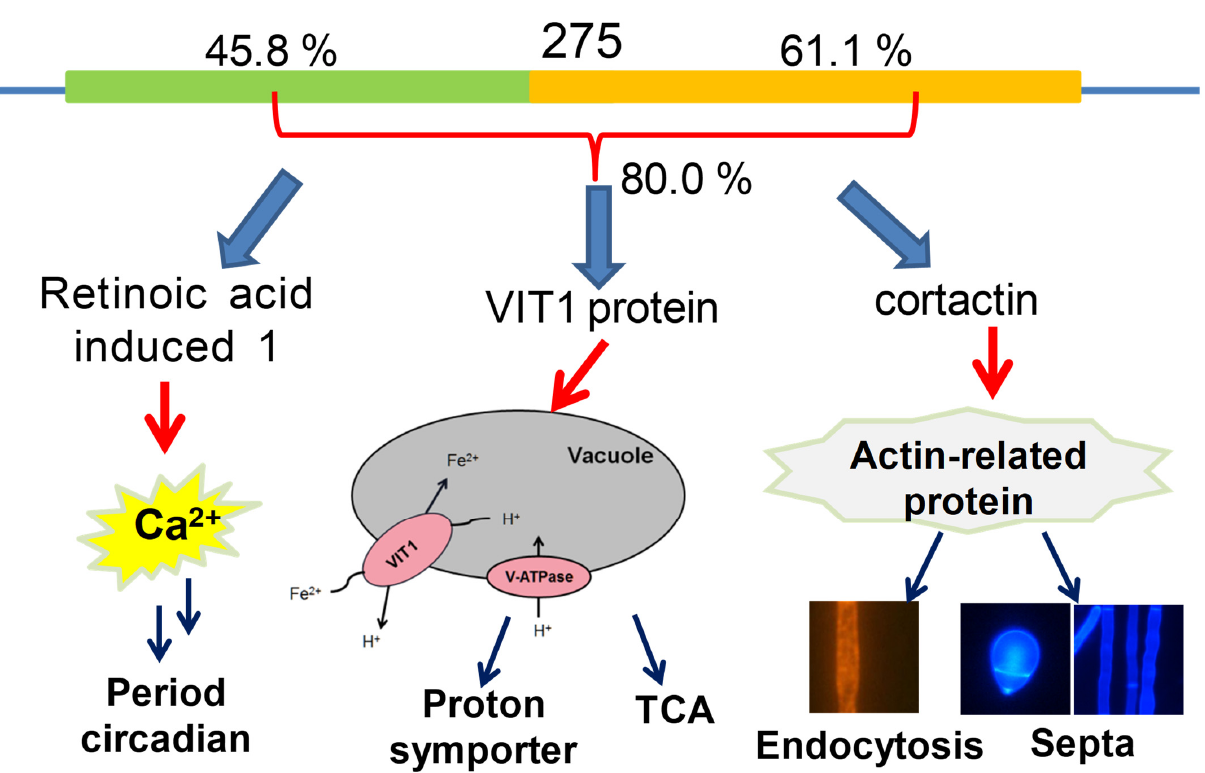
Figure 11. The proposed functions of 275 in the nematode-trapping fungus A. oligospora